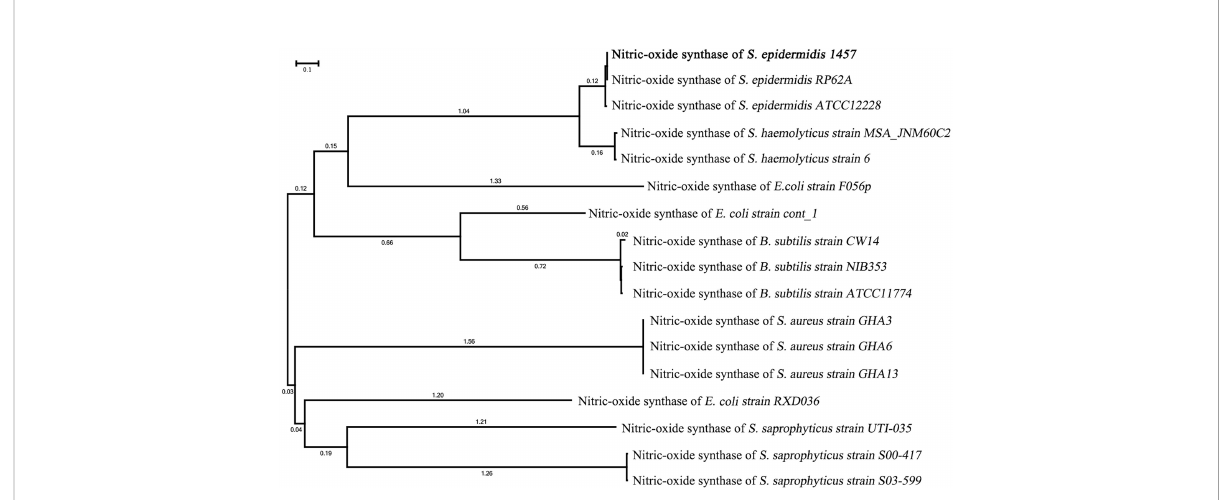
FIGURE 2 Phylogenetic tree of the NOS gene in S. epidermidis 1457. The phylogenetic tree of NOS of S. epidermidis 1457 showed that it had the closest homology with NOS of S. epidermidis RP62A and S. epidermidis ATCC 12228.